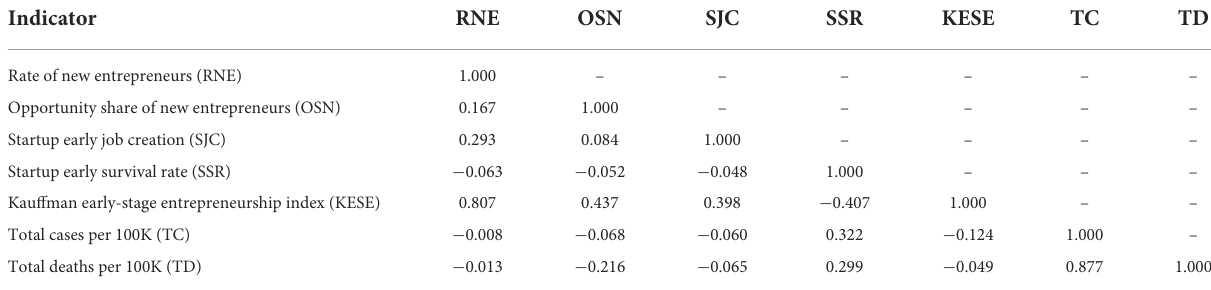
TABLE 2 Correlation matrix for all